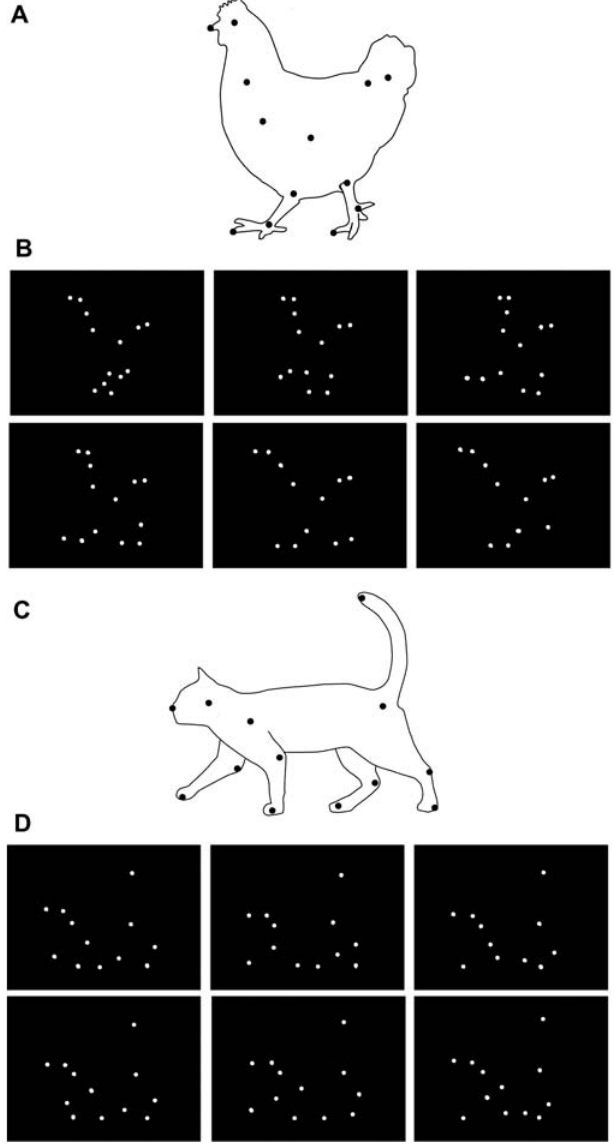
Figure 1. Point-Light Displays and Sample Frames from the Animation Sequences (A) The walking hen point-light display (above) The filled circles indicate the location of each point of light. (B) Six frames sampled from the walking hen animation (below) (C) The walking cat point-light display (above). (D) Six frames sampled from the walking cat animation (below). DOI: 10.1371/journal.pbio.0030208.g001